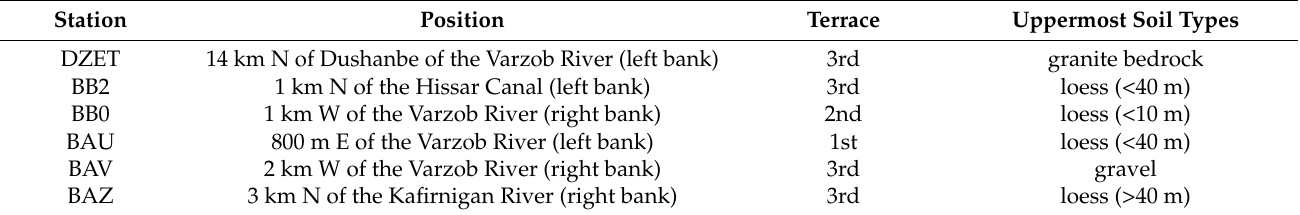
Table 4. The temporary seismic stations for standard spectral ratio (SSR) with details on location, position relative to the three terraces and prevalent soil types visible from the